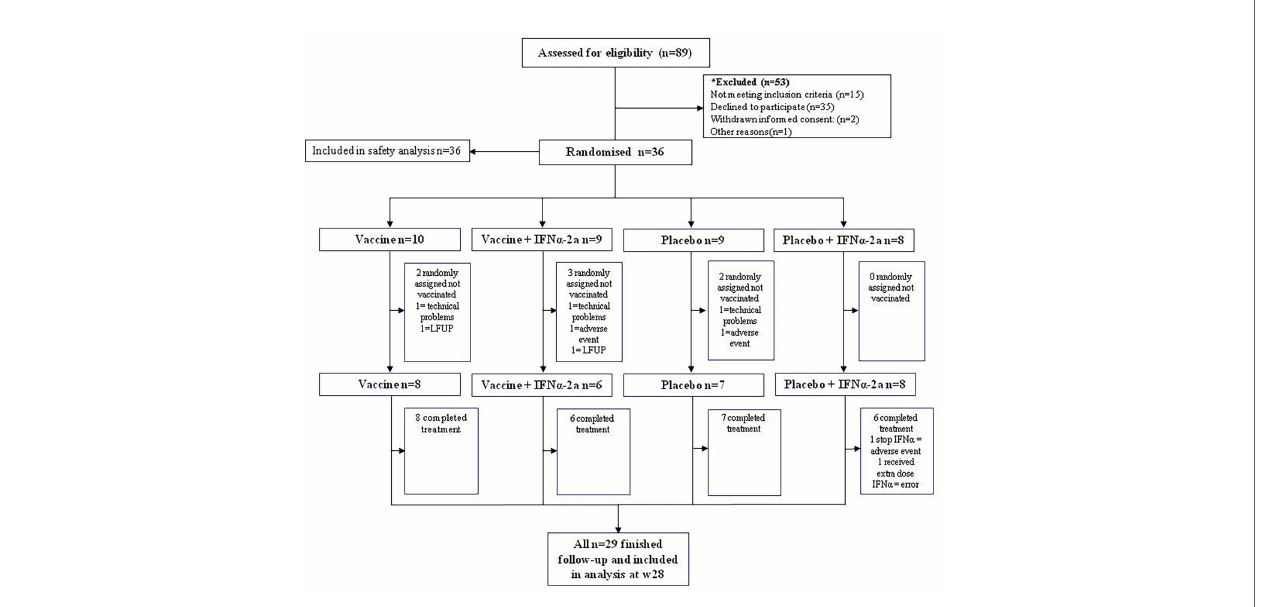
FIGURE 2 | Consort diagram of participants ’